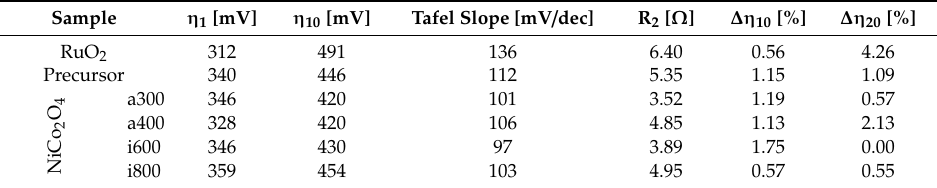
Electrochemical properties of the obtained samples and RuO 2 during OER process: overpotential η 1 and η 10 , Tafel slope, R 2 equivalent resistance values, and relative changes in overpotentials over time ∆ η